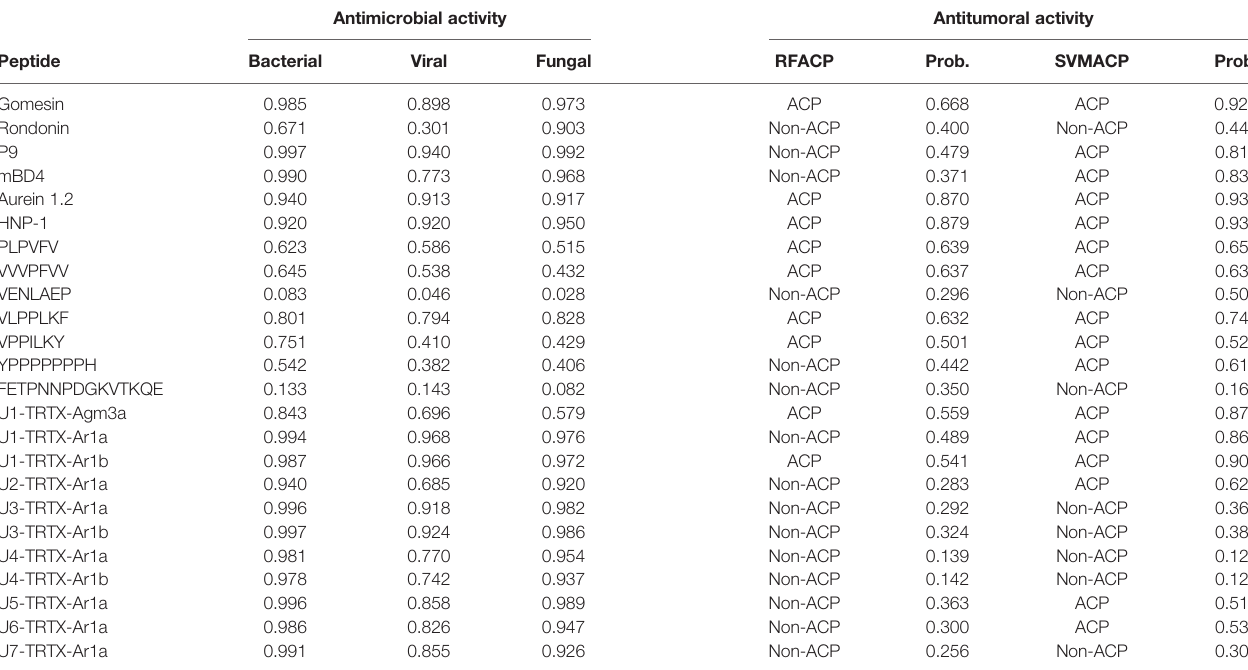
TABLE 3 | In silico predictions of biological activities of validated toxins identi fi ed in the venom of A. rondoniae